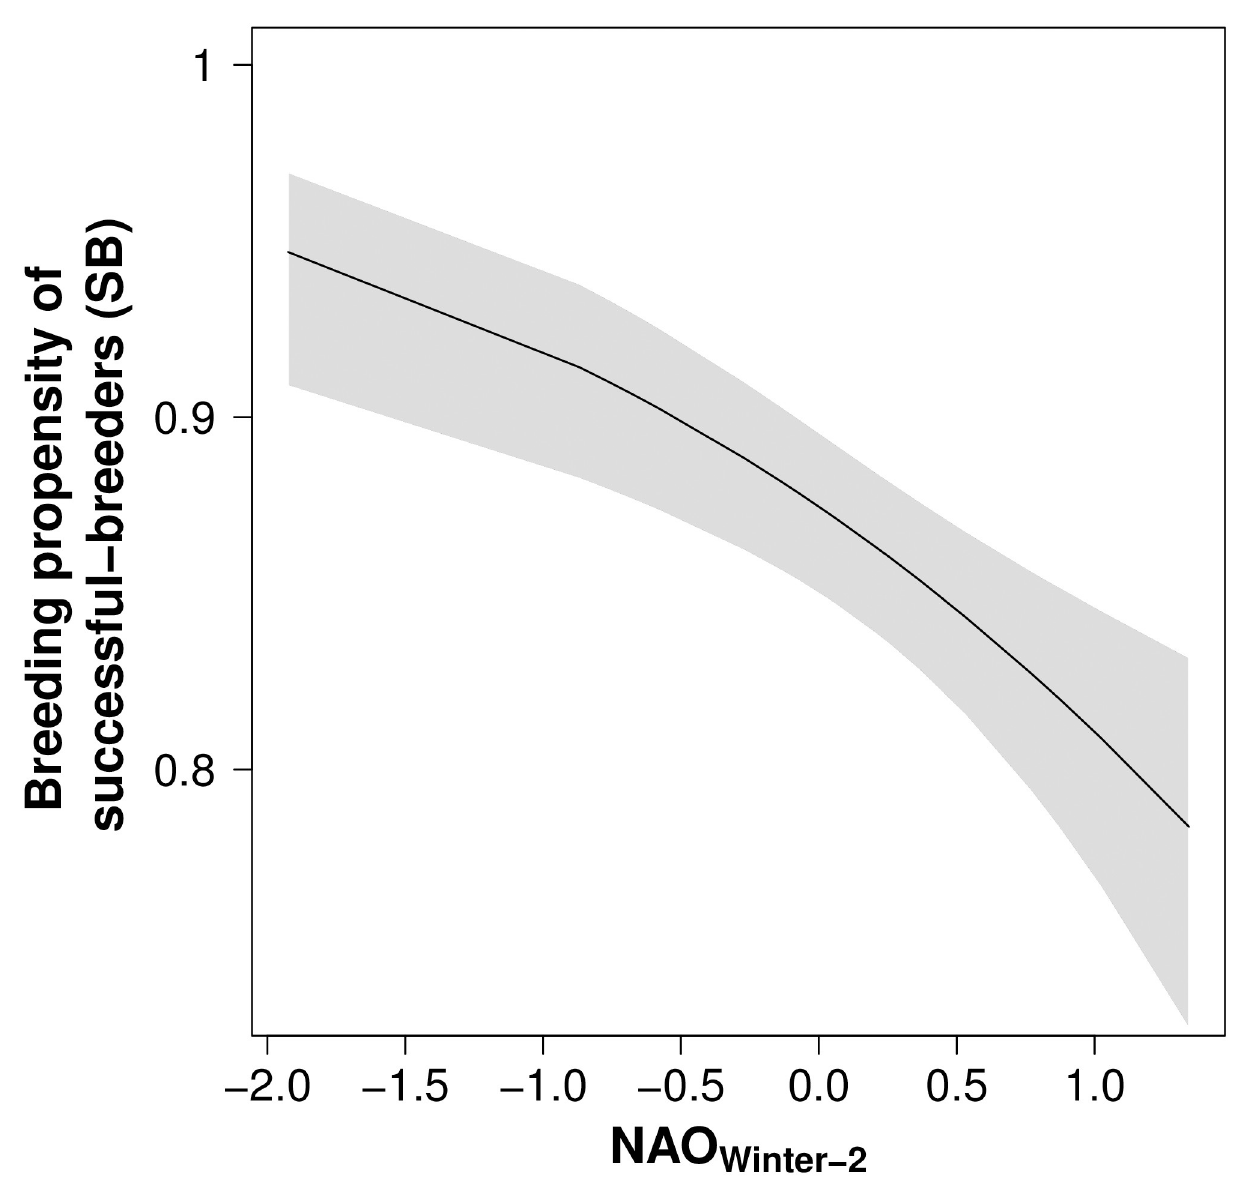
Fig 4. Breeding propensity of successfully breeding Manx shearwaters decreased with increasing values of the North Atlantic Oscillation (NAO) during the non-breeding season (from December to March) with a two-year lag. Grey shading shows 95%